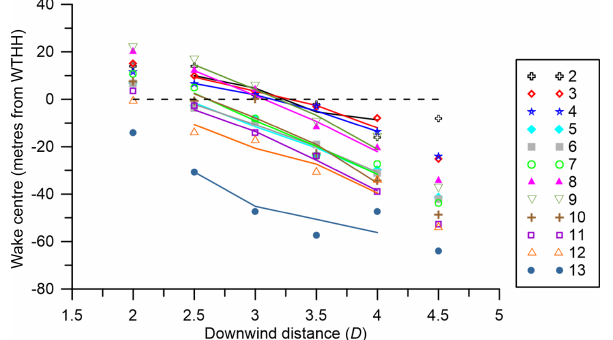
Figure 17. Mean vertical location of the wake centre conditionally sampled by inflow tower wind speed at 78m height (in ms − 1 ) for different distances downstream of the wind turbine location (A type